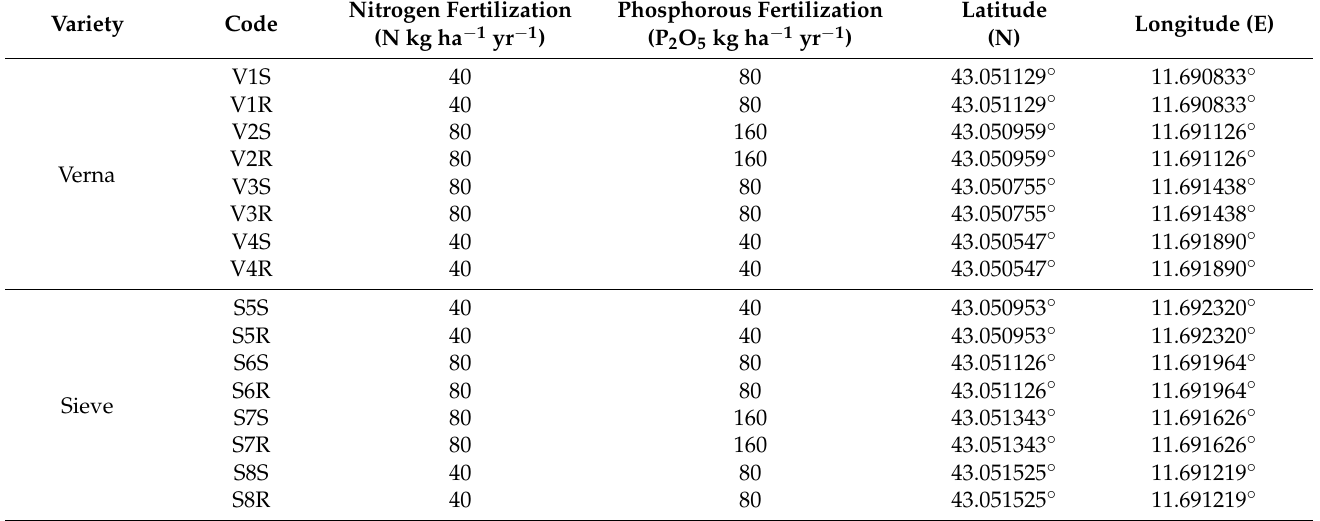
Table 2. Samples analyzed. The code, wheat variety, the fertilization of the plot, and their geographical position is reported. Numbers in the sample code refer to the plots. “S” and “R” in the sample code indicate soil and rhizosphere fraction,